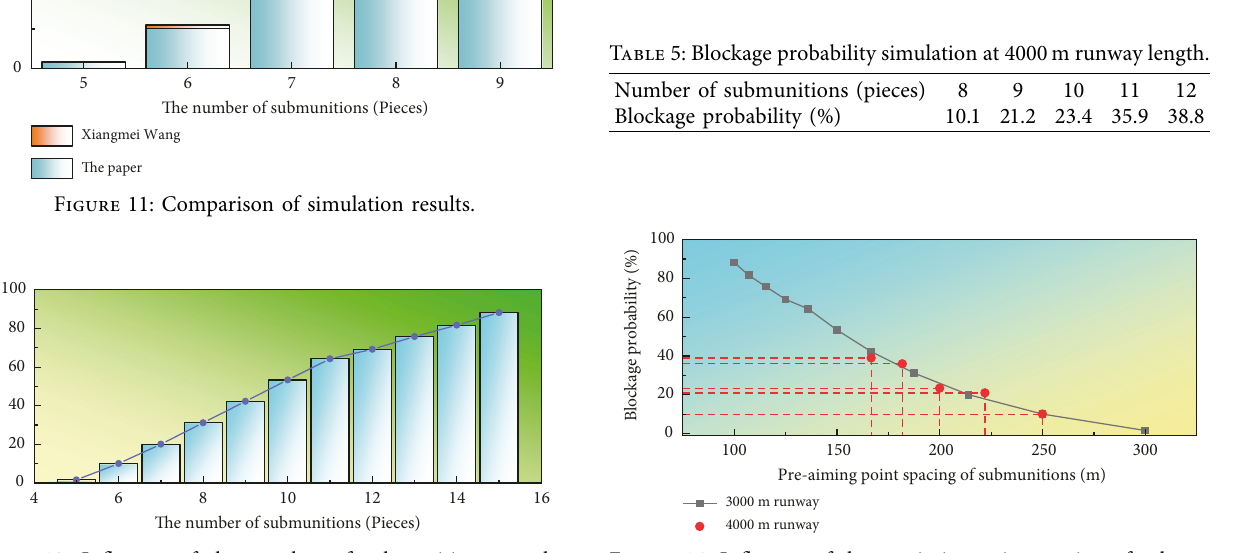
Figure 14: Influence of the preaiming point spacing of submu- nitions on the blockage probability in different runway